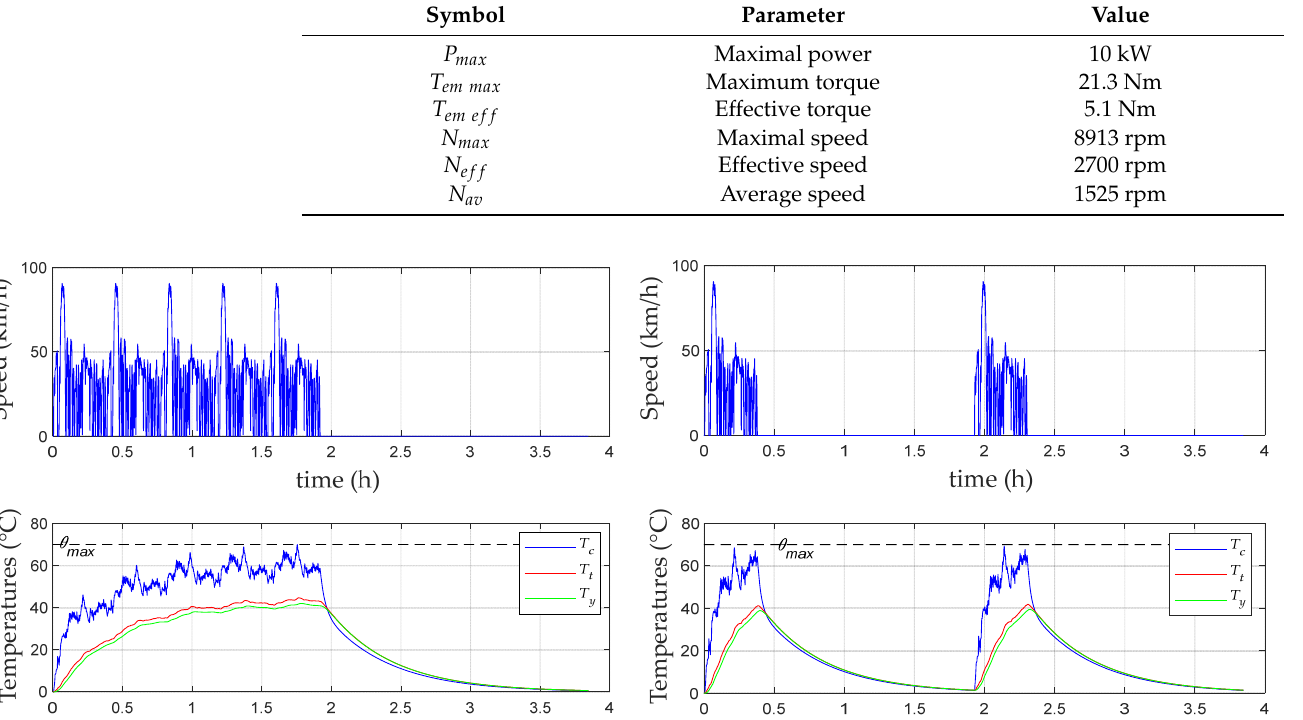
Table 4. Specific data of motor torque-speed profiles with a gear box ratio G = 10.